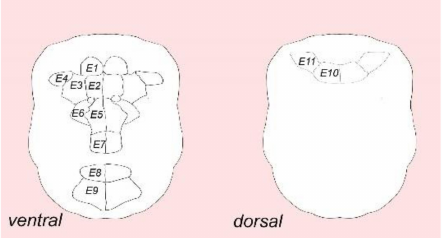
Figure 2. Multiciliated cells of ciliary fields of Dimorphilus gyrociliatus dwarf male. The diagram is based on the results presented in [3,4]. The multiciliated cells distriburion pattern is adapted from [3,4] Copyright © 1988 Alan R. Liss, Inc. Apical end is up, relative size is not to scale. E1–E11 represent multiciliated cells of anterior ventral, posterior ventral and dorsal ciliary